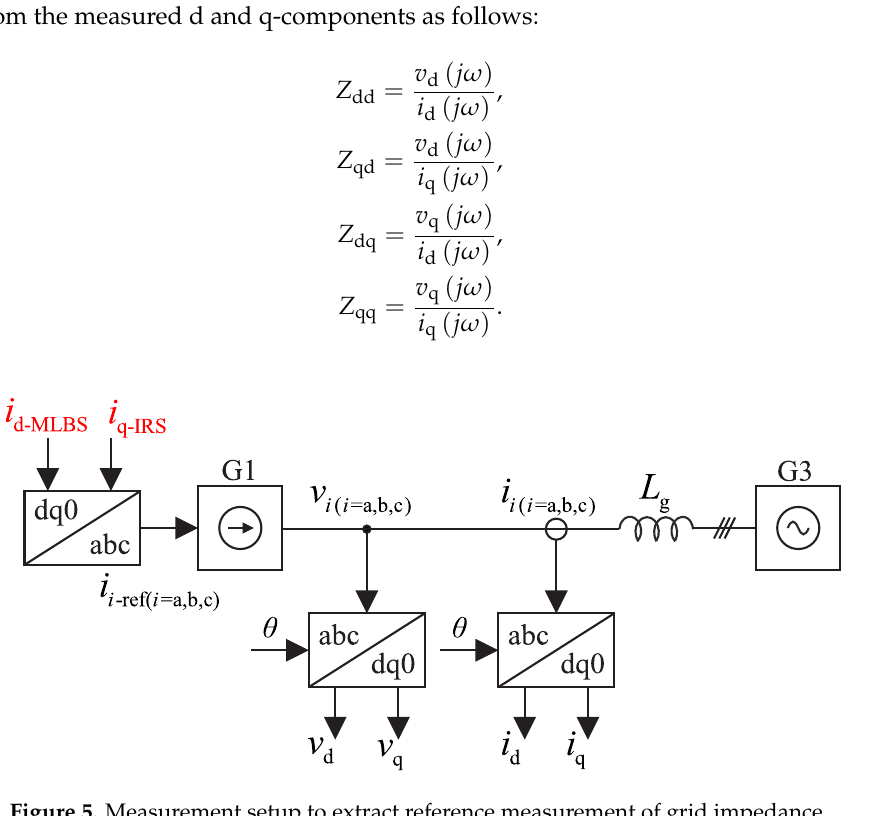
Figure 5. Measurement setup to extract reference measurement of grid